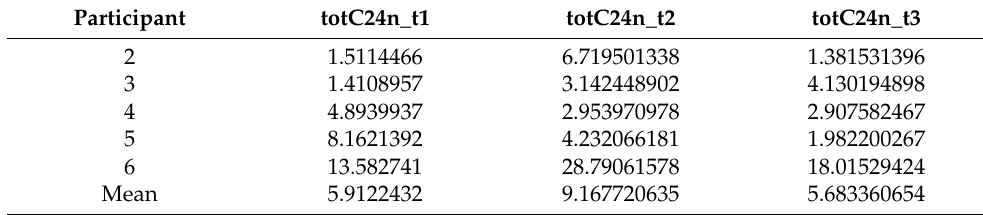
Table 28. TotC24, nectar 10 mL (%C2–4) individual and mean measurements at three assessment time points.